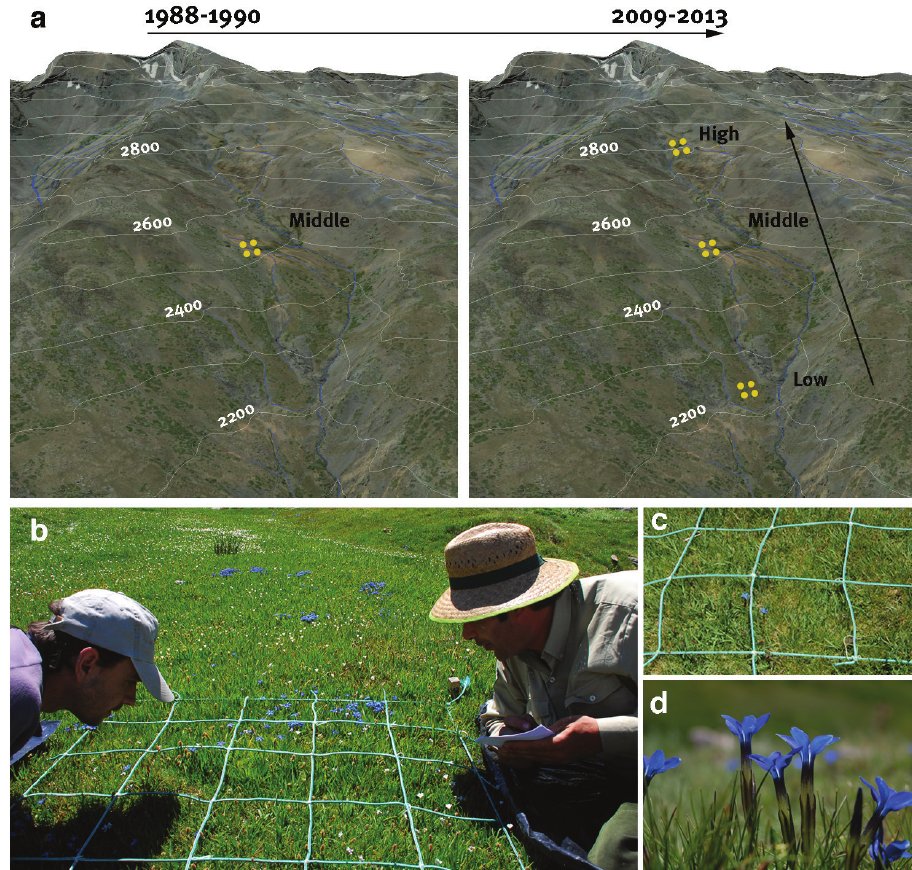
Figure 5. Schema of the sampling design. a Different sampling plots were distributed along an altitu- dinal gradient. For the middle-altitude locality the plots were sampled in two periods: 1988–1990 and 2009–2013. View of a sampling plot of 1 × 1 m ( b ) that was divided into quadrats of 25 × 25 cm to facilitate counting ( c ) and to record the cover-abundance and the number of individuals in flowering ( d ) or in fruit